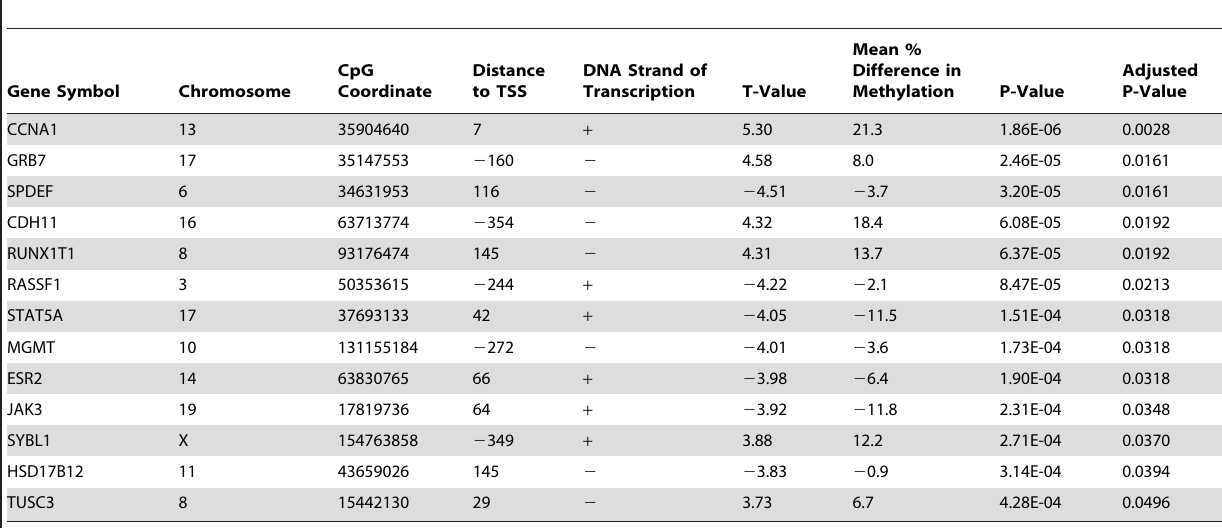
Positive T-Values correspond with higher methylation in HPV( + ) while negative T-Values correspond with higher methylation in HPV( 2 ) tumors.